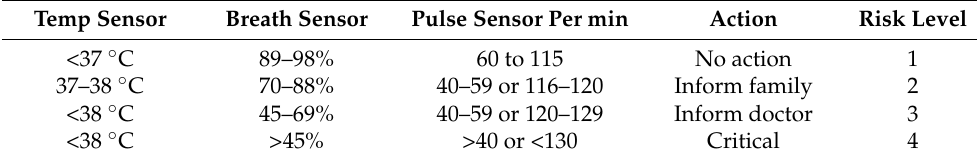
Table 11. Decision making about the patient’s